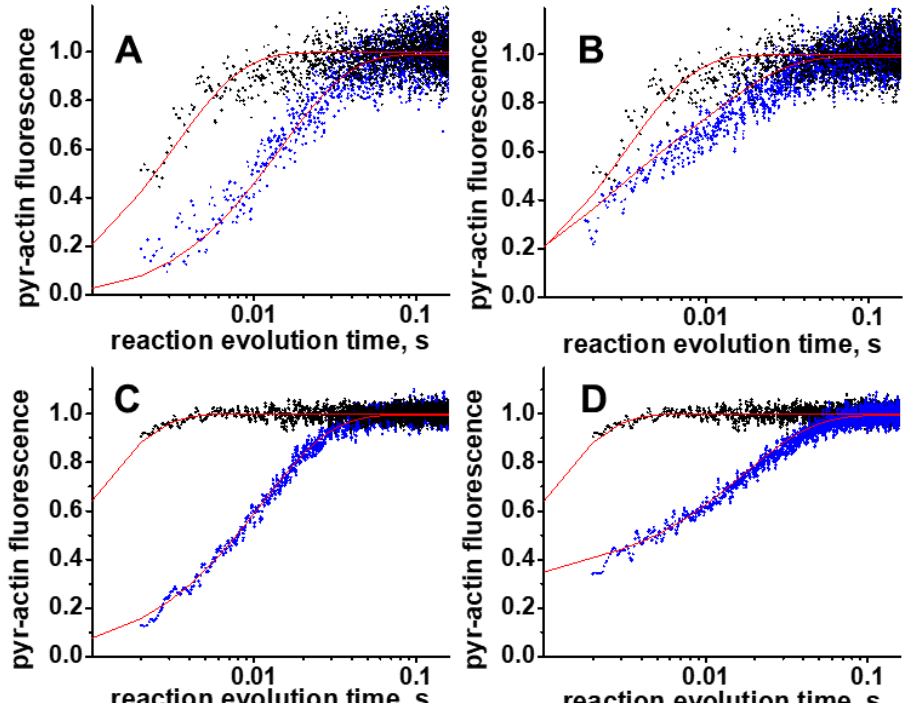
Figure 6. Typical transients, obtained in the study. ( A , B ), WT, and ( C , D ) mutant myosin construct. ( A , C ), the ATP-induced actomyosin dissociation experiment. Pyrene-labeled actomyosin is rapidly mixed with ATP ([ATP] = 30 µ M, blue dots, 600 µ M, black dots). ( B , D ), the ADP inhibition experiment. Pyrene-labeled actomyosin is rapidly mixed with the premixed ATP and ADP ([ATP] = 600 µ M, [ADP] = 0 µ M, upper trace, black dots, and [ADP] = 100 µ M, lower trace, blue dots). Normalized pyrene actin fluorescence reflects actomyosin dissociation. Red traces, fits to the numerical solution of the system of differential equations (Supplementary Equations (S1) and (S2)). For the ATP-induced actomyosin dissociation experiment, the fitted parameters are k +1T , k − 1T , k +2T , k − 2T . For the ADP inhibition experiment, the fitted parameters are k +1D , k +1D . A different signal-to-noise ratio reflects different labeling efficiency of actin.